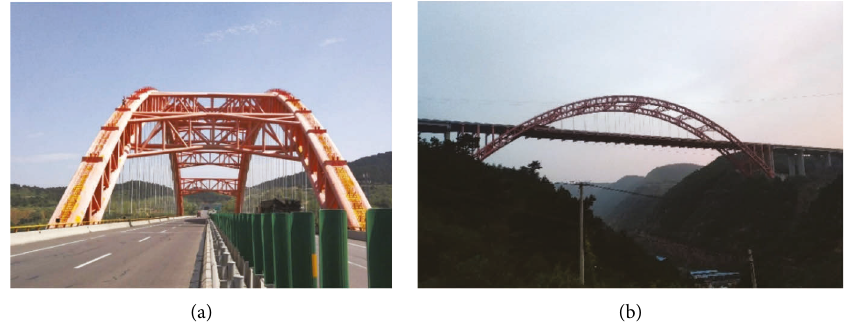
Figure 1: Beisheng CFST arch bridge. (a) Arch bridge lane. (b) Overall state of an arch bridge.